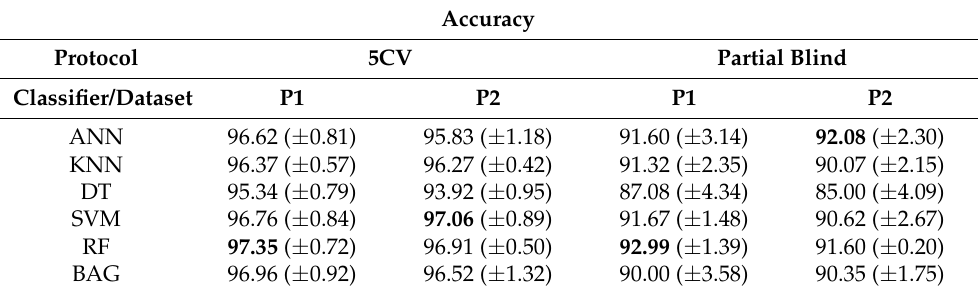
Table 2. Accuracy of different classifiers for arrhythmia classification in the two proposed protocols.